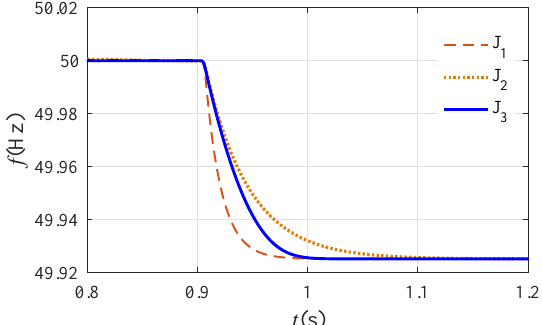
Figure 17. Frequency response under different virtual inertia when disconnected from the